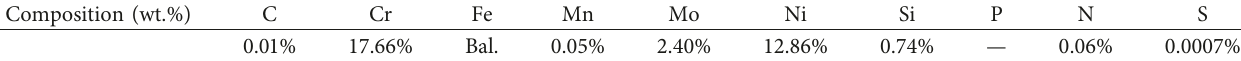
Table 1: Chemical composition table of 316L stainless steel powder. Composition (wt.%)